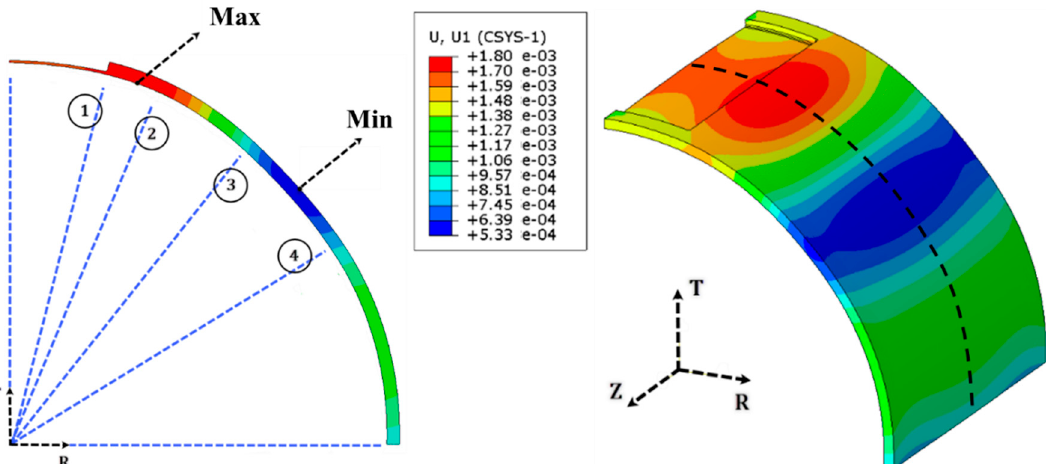
Figure 13. Radial displacement [m] on the deformed shape (magnification 5×) of the pipe section in the damaged part; highlights of the geometric Points considered in Figure 12.